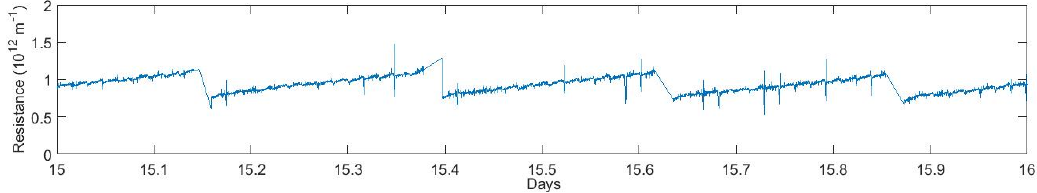
Figure 2. One-day data of the resistance (membrane and fouling, temperature corrected) for the HFUF, flux 50 L/m 2 h (water temperature 7.7 °C, normalized flux 75 L/m 2 h).